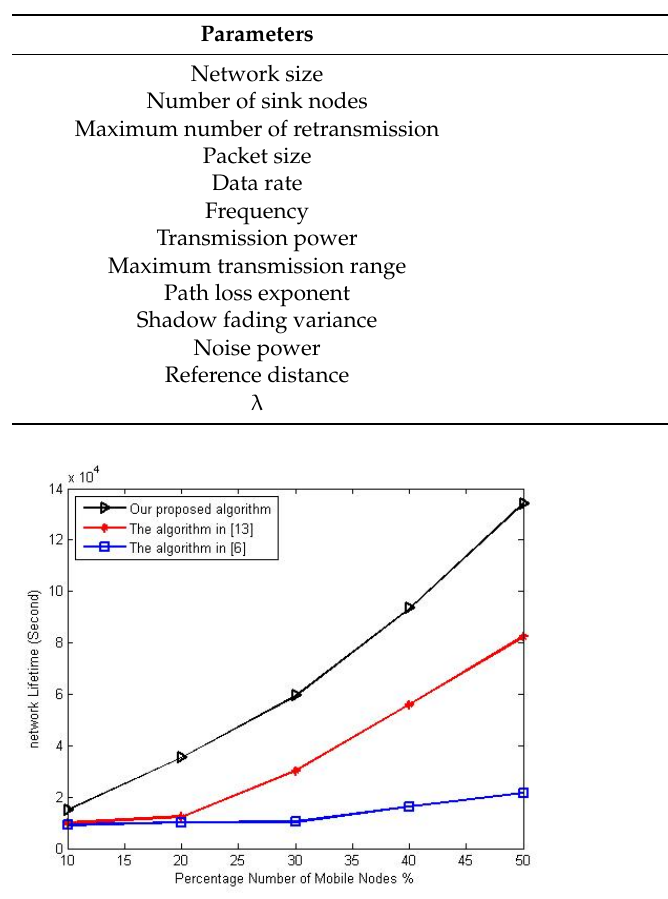
Table 5. Simulation environment parameters [8,27].